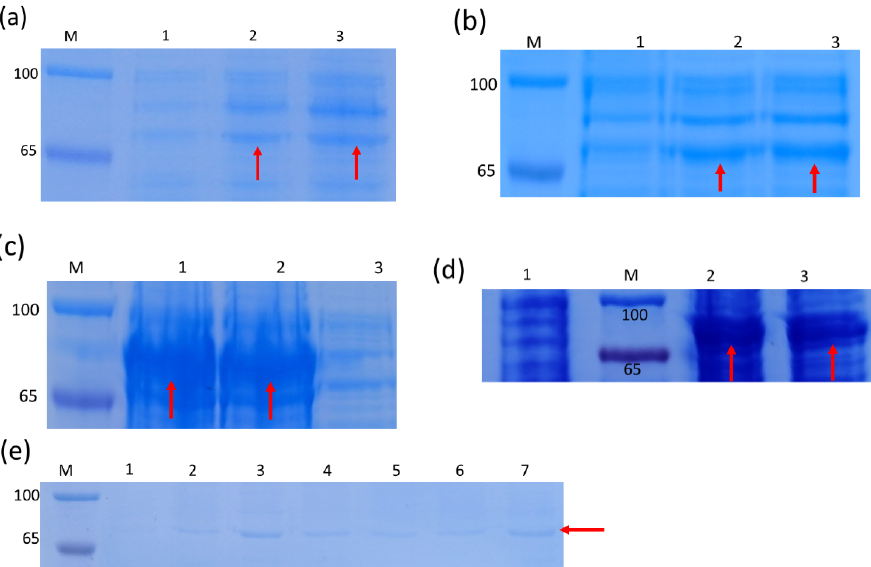
Figure 4. SDS-PAGE analysis of the expressed product of the recombinant strain pET28a-PmDXS. M. Protein molecular weight standard. The molecular weight of the target protein, which is about 70.4 kDa (red arrow). ( a ). The supernatant of bacterial solution at 16 ◦ C (1. Recombinant strain without IPTG induction). 2. Recombinant strain with 0.5 mM IPTG induction for 16 h. 3. Recombinant strain with 1.0 mM IPTG induction for 16 h). ( b ). Induction of bacterial solution under 16 ◦ C (1. Recombinant strain without IPTG induction; 2. Recombinant strain with 0.5 mM IPTG induction for 16 h; 3. Recombinant strain with 1.0 mM IPTG induction for 16 h). ( c ). The precipitate of the bacterial solution at 16 ◦ C (1. Recombinant strain with 0.5 mM IPTG induction for 16 h; 2. Recombinant strain with 1.0 mM IPTG induction for 16 h; 3. Recombinant strain without IPTG induction). ( d ). Induction of bacterial solution under 37 ◦ C (1. Recombinant strain without IPTG induction; 2. Recombinant strain with 0.5 mM IPTG induction for 4 h; 3. Recombinant strain with 1.0 mM IPTG induction for 4 h). ( e ). The supernatant of the bacterial solution at 37 ◦ C (1. pET28a strain with 1.0 mM IPTG induction for 4 h; 2~7. Recombinant strain with 0, 0.1, 0.3, 0.5, 1.0, and 2.0 mM IPTG induction for 4 h).